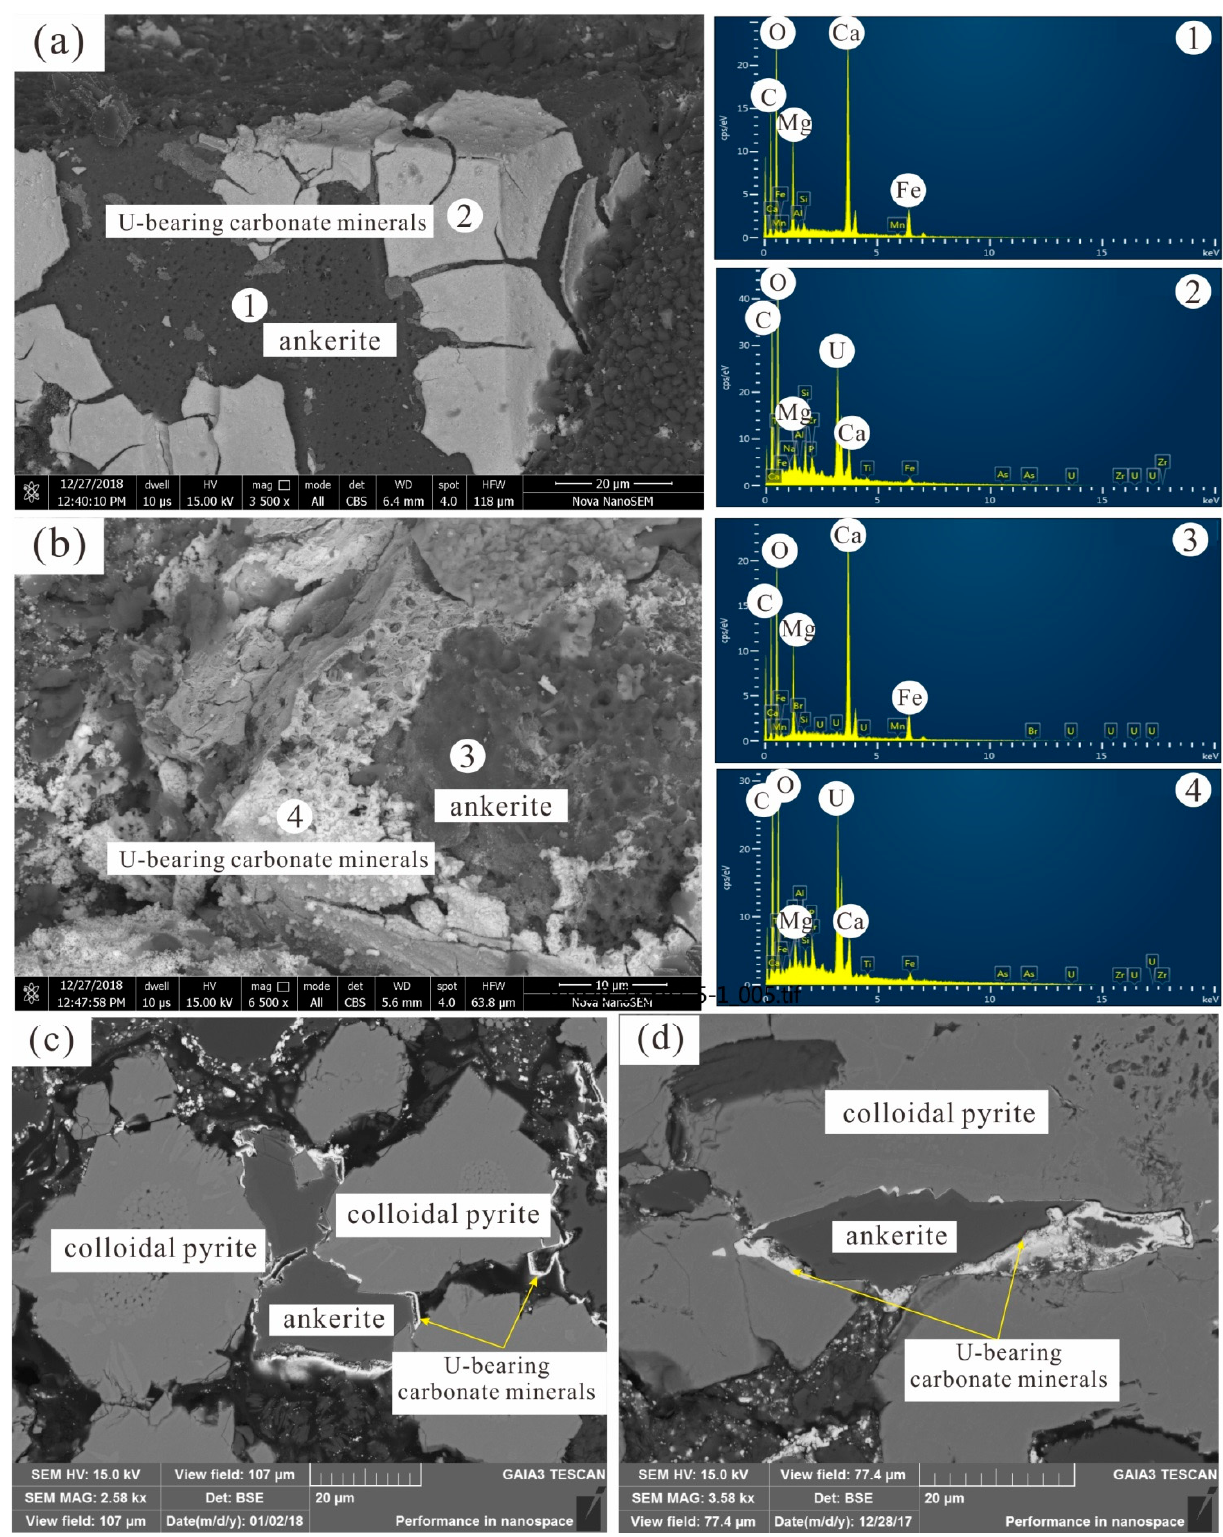
Figure 4. Back scattered electron (BSE) images showing the morphological characteristics of U-bearing ankerite. ( a ) U-bearing carbonate minerals occurred as a thin shell around the ankerite in intergranular pores; ( b ) U-bearing carbonate minerals occurred as a thin shell around the ankerite in intergranular pores; ( c ) U-bearing carbonate minerals around the ankerite and colloidal pyrite; ( d ) U-bearing carbonate minerals around ankerite, and then surrounded by colloidal pyrite.